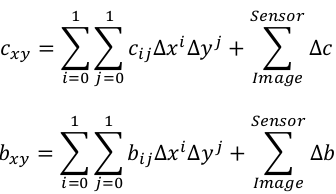
Figure 2. Typical radiometry fix layout for an ADS image, with bilinear interpolation of the correction parameters at point